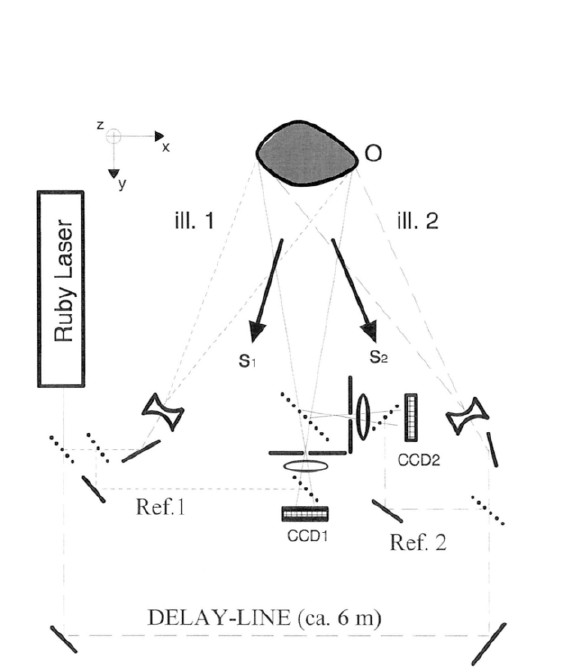
FIGURE 8 2-D measurement of a cognac glass: (a) phase map recorded with camera I leading to the deformation along the sensitivity vector SI ; (b) phase map recorded with camera 2 resulting in the deforma tion along the sensitivity vector 52; (c) deformation along a line at the height h of the glass. obtained by combination of the deformations along the sensitivity vectors 5 1 and